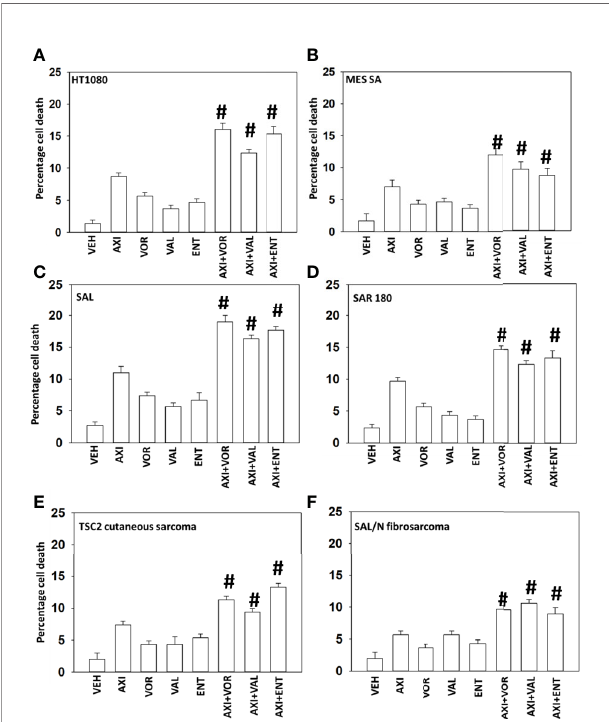
FIGURE 1 | Axitinib interacts with HDAC inhibitors to kill sarcoma cells. (A – F) Sarcoma cells human (HT1080, MES) and mouse (SAL, SAR180, TSC2, SAL/N) were treated with vehicle control, axitinib (50 nM), entinostat (50 nM), vorinostat (500 nM), sodium valproate (250 m M) alone or in combination as indicated in the graphical panels. Twenty-four h later, cells were isolated, and viability determined by trypan exclusion assays in triplicate (n = 3 +/-SD). # p < 0.05 greater than axitinib alone